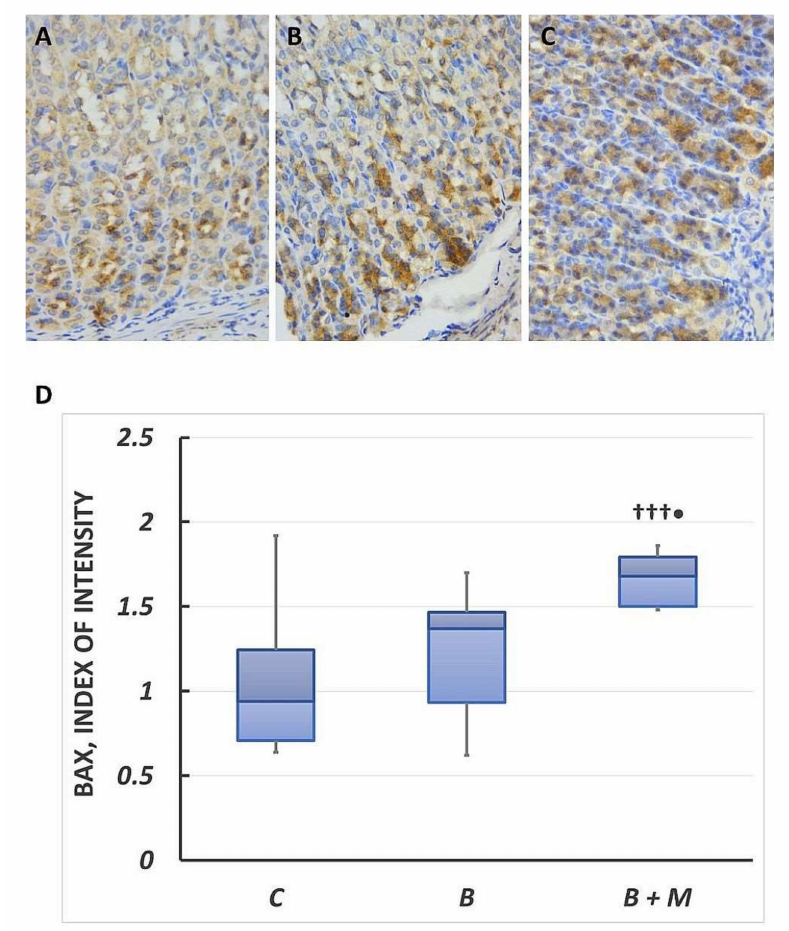
Figure 2. Melatonin effect on Bax protein expression. Immunohistochemical detection of Bax in gastric mucosa. Controls ( A ); burned rats ( B ); burned melatonin-treated rats ( C ). The antigen site appears as a brown color. Representative images. Original magnification, 400 × . Score index of Bax positive immunostained cells ( D ). Results are given as box plot, with median, 25th- and 75th-percentile values, and min and max values. ††† p < 0.001 vs. burned, non-treated group; • p < 0.05 vs. control group. Controls (C); burned rats (B); burned melatonin-treated rats (B +